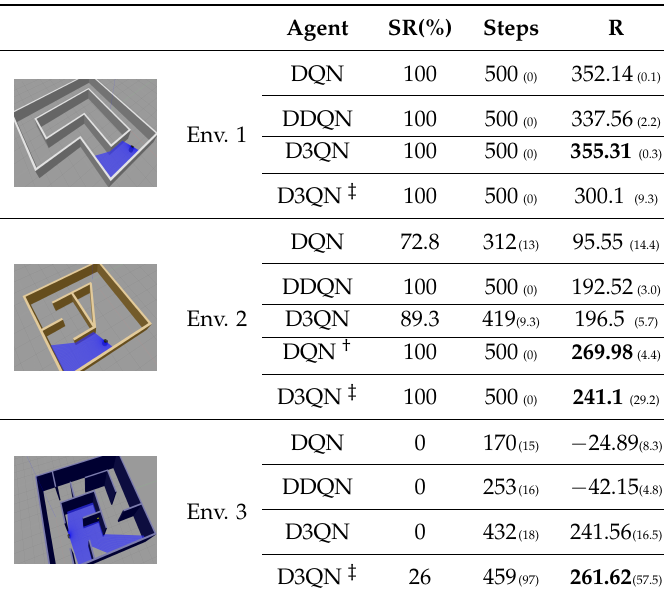
Table 3. Mean evaluation results in all environments for DQN, DDQN and D3QN agents trained with . Superscript † refers to an agent that was allowed to train briefly before its evaluation on that R F scenario, while ‡ does to an agent retrained with R aug